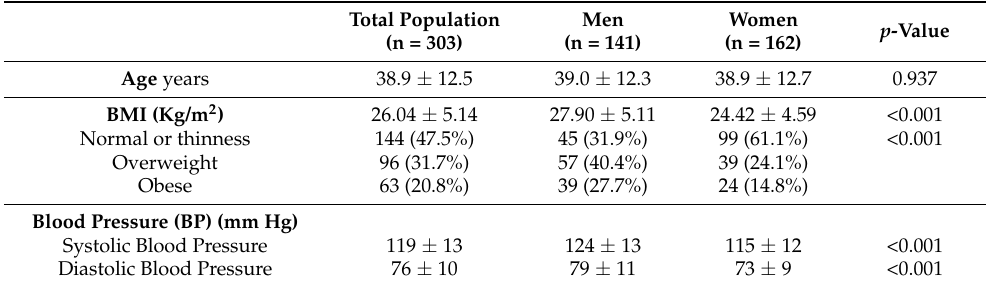
Table 1. Baseline demographic, anthropometric, and lipid characteristics of the total population, with men and women taken